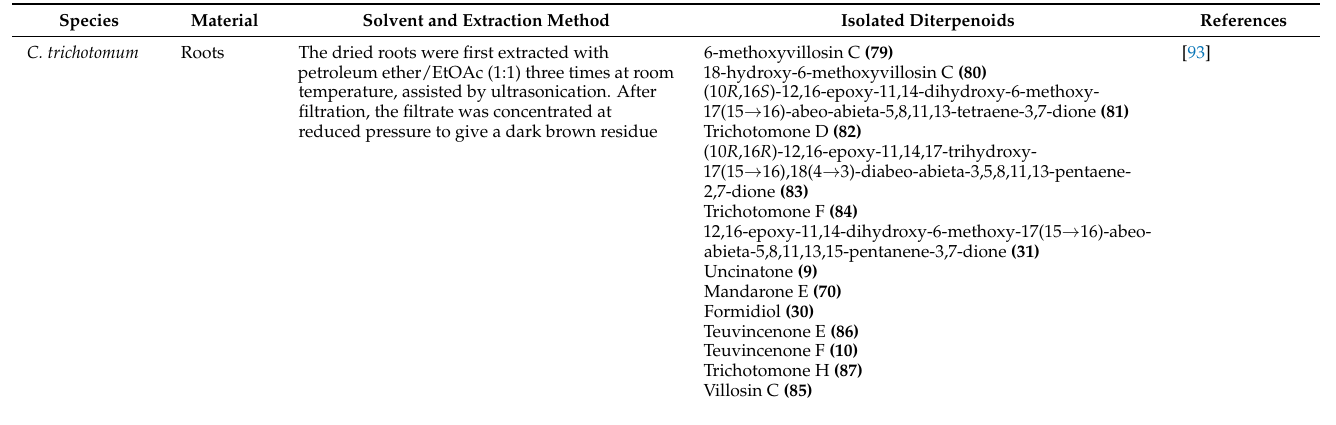
Table 11. The diterpenoid extraction methods and C. trichotomum plant materials for diterpenoid isolation. Species Material Solvent and Extraction Method Isolated